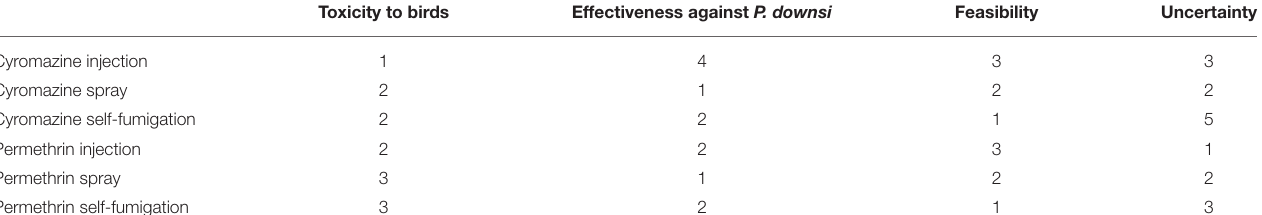
TABLE 4 | Risk scores for each alternative (chemical/mode of application combination) and criterion that informed the Multi-Criteria Decision Approach (MCDA) model. Toxicity to birds